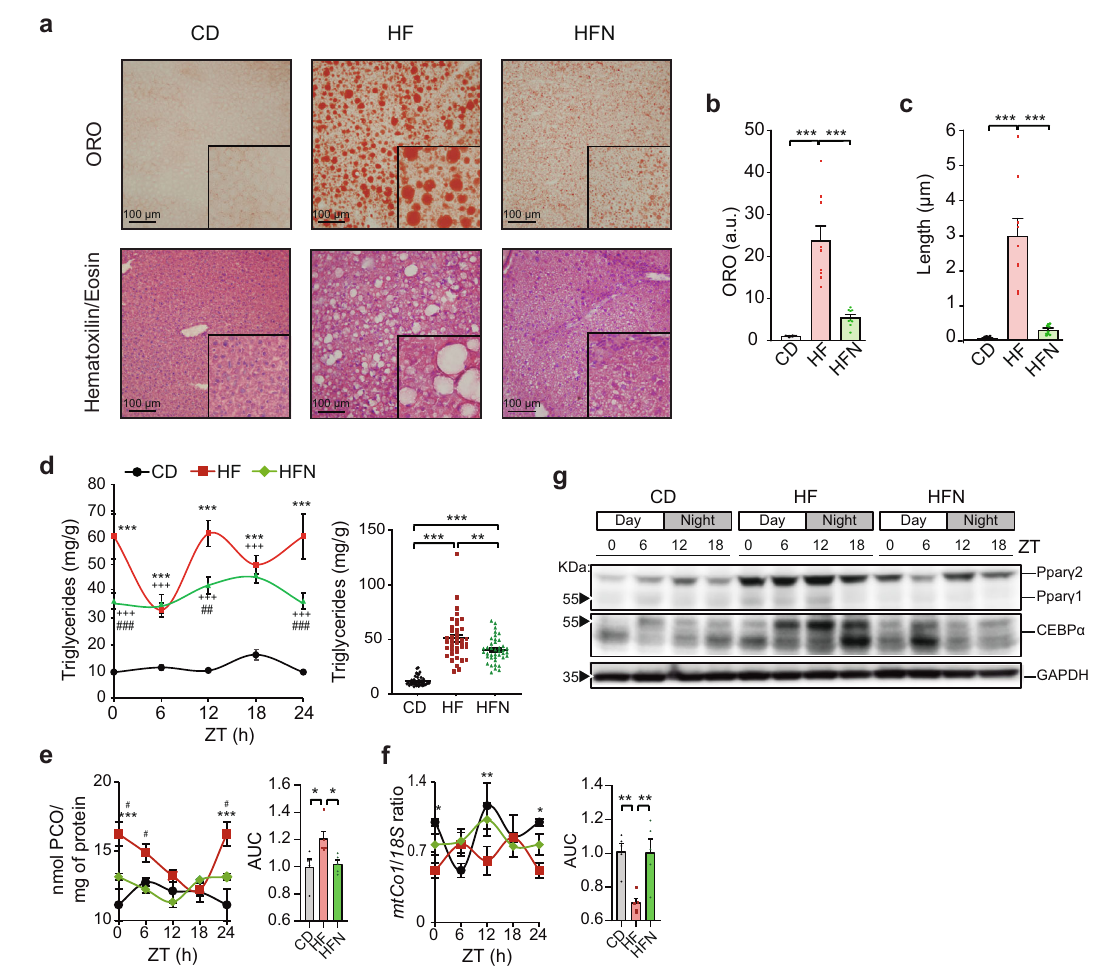
Fig. 2 | NAD + chronotherapy ameliorates NAFLD. a Representative hepatic his- topathology. Upper panel: Oil-red-O stain (ORO). Lower panel: hematoxilin/eosin. Images were acquired at ×20 optical magni fi cation, and a detailed ×100 digital magni fi cation is shown. Data were reproduced in three biological and three tech- nical replicates. b Quanti fi cation of ORO signal (arbitrary units). Signal for control mice was set to 1 ( n =3 biological and three technical replicates). c The length of lipid droplets was compared between groups ( n =3 biological and three technical replicates). d Distribution of hepatic triglyceride content across the day (left), and comparisons from all measurements (right) ( n =5 mice per time-point, with 2 technicalreplicates). e Proteincarbonyllevels(PCO)inliverlysatesweremeasured at the indicated times of day ( n =5 mice per time point, two technical replicates). AUC area under the curve. f Relative mtDNA copies of mtCO1 respect to 18S DNA